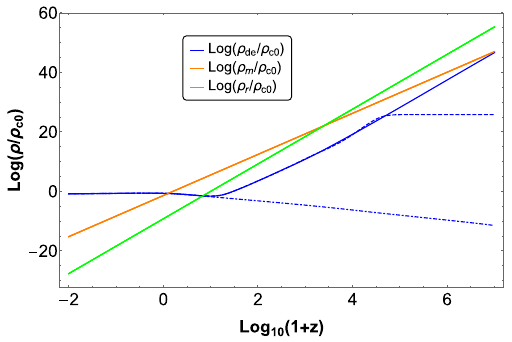
Fig. 1 We depict the evolution of the energy density of dark energy ρ ρ de (blue), dark matter (including baryons) m (orange) and radiation ρ = − 1 . 20, σ = 0 . 3 r (green) as functions of the redshift z , for s and λ = 150. The solid blue line corresponds to the initial conditions x i = 0 . 0108, y i = 0 . 00765, u i = 9 . 3 × 10 − 30 , (cid:2) i = 0 . 999788, dashed blue line to x i = 1 × 10 − 9 , y i = 4 × 10 − 7 , u i = 9 . 1 × 10 − 30 , (cid:2) i = 0 . 999877, and dot-dashed blue line to x i = 1 × 10 − 33 , y i = 1 × 10 − 41 , u i = 1 . 05 × 10 − 29 , (cid:2) i = 0 . 999877. It is observed the two new scaling regimes during the radiation and dark matter era. To obtain this plot we have found the current values for the fractional energy densities ( 0 ) = 0 . 68 and dark matter Ω ( 0 ) = 0 . 32, at redshift of dark energy Ω m de z = 0,accordingtoPlanckresults[7].Also,duringthescalingradiation ( r ) < 0 . 045[127],andthe epochwehaveimposedtheBBNconstraint Ω de constraint for the field energy density during the scaling matter epoch Ω ( m ) < 0 . 02 (95% CL), at redshift z ≈ 50, from CMB measurements de [125]